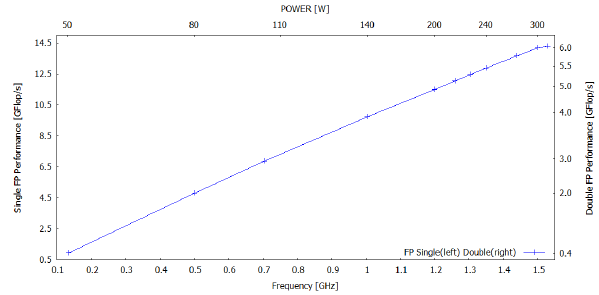
Figure 4: Nvidia V100 GPU floating point performance as a function of graphics clock rate. Electrical power draw corresponding to the set frequency is indicated on the upper